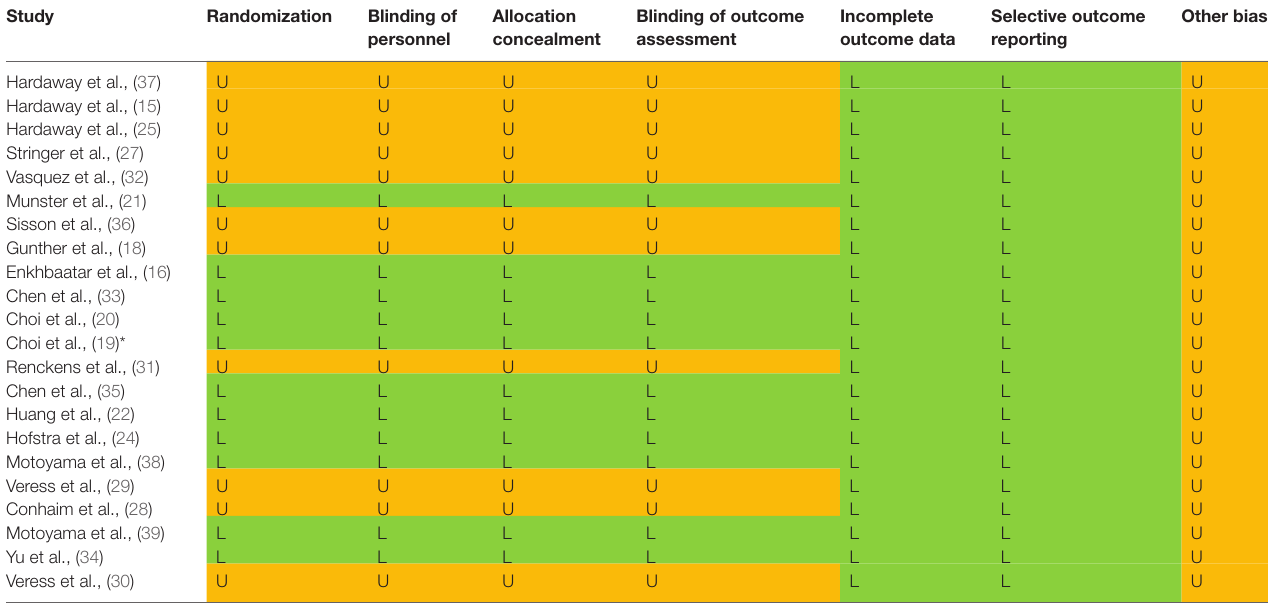
taBLe 6 | Risk of bias